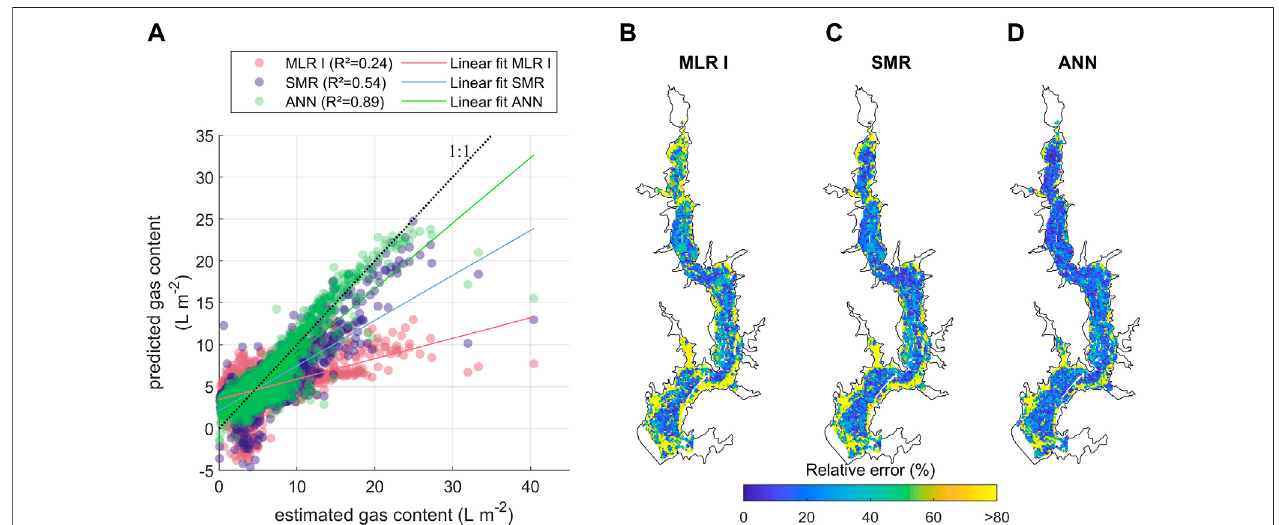
FIGURE 5 | (A) Scatter plot of predicted vs. estimated gas content and gas content for the survey in 2019 using three different empirical models (model MLR I are pink dots, SMR are the purple dots, and ANN are the green dots). Colored solid lines show linear regressions for each model with the following regression equations: MLR I y (cid:1) 3 . 46 + 0 . 24 x (pink line); SMR y (cid:1) 2 . 11 + 0 . 54 x (blue line), and ANN y (cid:1) 1 . 02 + 0 . 78 x (green line). The dotted black line shows a 1:1 ( y (cid:1) x ) relationship. (B) SpatialdistributionoftherelativeerrorbetweenpredictedandestimatedgascontentfromthemultiplelinearregressionI(MLRI)inwhich21.6%ofthegridcellshad errors largerthan 80%. (C) Relative errorofthepredictedgascontentfrom thestepwise multiple regression(SMR)in which17.7% ofthe gridcells had errorslarger than 80%. (D) relative error of the gas content predicted by the arti fi cial neural network (ANN) in which 10.7% of the grid cells had error larger than 80%.